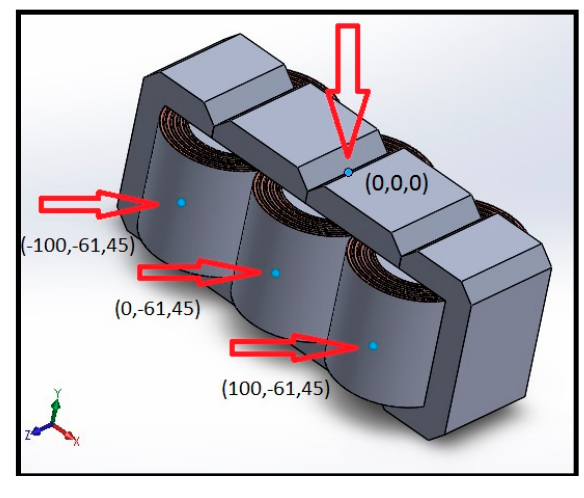
Figure 5. Thermocouple locations.